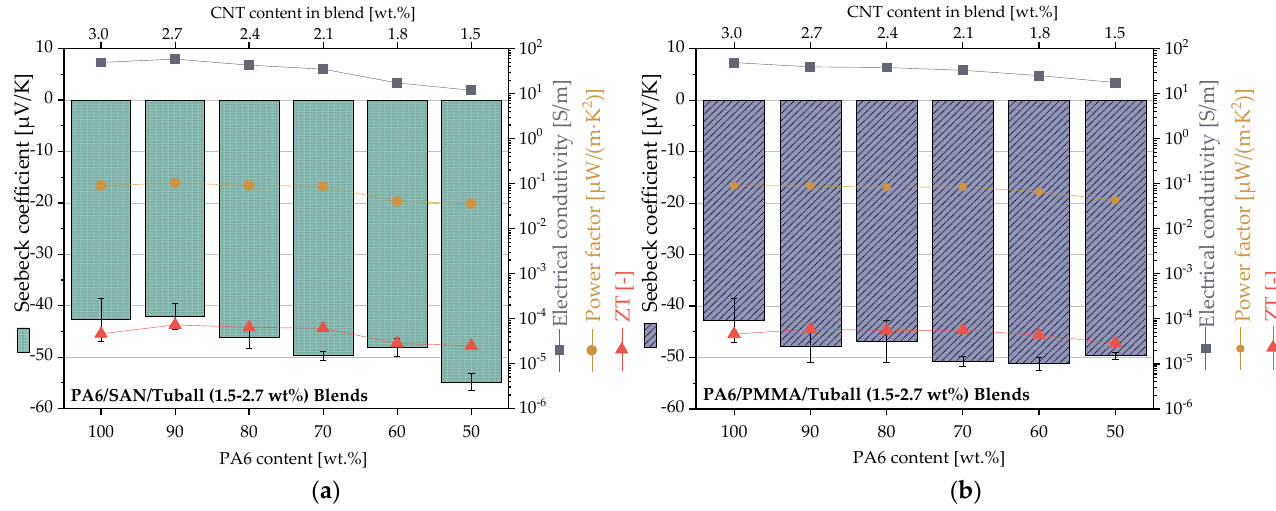
Figure 11. Thermoelectric parameters of ( a ) PA6/SAN/SWCNT blends and ( b ) PA6/PMMA/SWCNT blends having different ratios of the blend components and SWCNT contents (2.7 – 1.5 wt.%) to reach a constant SWCNT content of 3 wt.% in the PA6 component for all blend compositions (values are given in Tables A2 and A3).